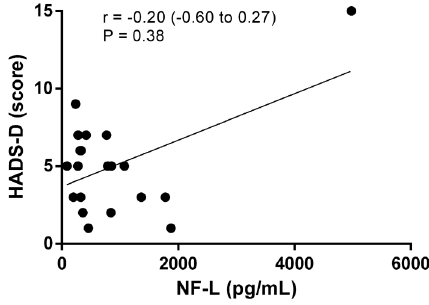
Figure 3. Correlation analysis between scores of the Hospital Anxiety and Depression Scale-depression (HADS-D) and neuro- fi laments light chain (NF-L) levels.